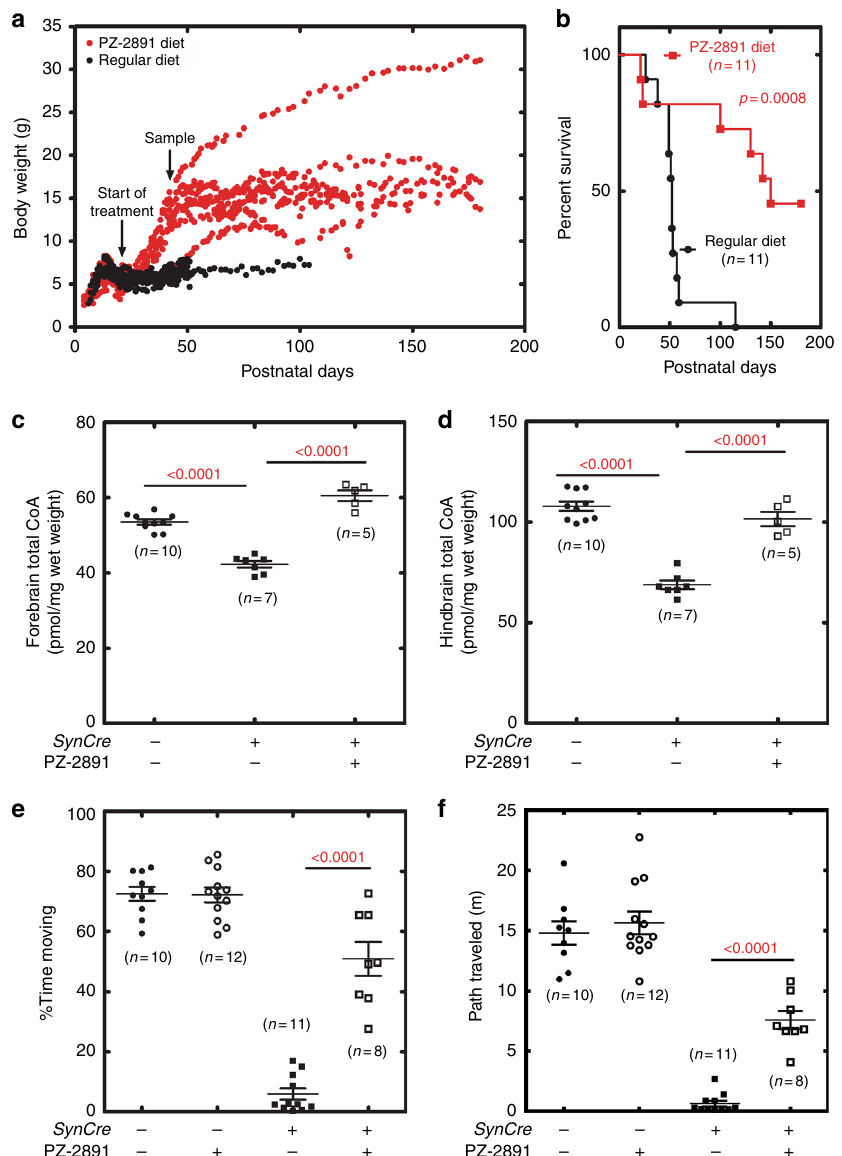
Fig. 7 PZ-2891 therapy in SynCre + PANK1,PANK2 neuronal knockout mice. Male and female mice were randomized into the experimental groups when they were genotyped, and the numbers of mice used in each analysis are shown in parenthesis in the fi gure panels. a Weight monitoring of double knockout mice maintained on the control diet (black circles) or on a diet with PZ-2891 (red circles). The start of treatment and the time of sample collection are indicated with arrows on the fi gure. b Lifespan of double knockout mice with (red line) or without (black line) PZ-2891 treatment. c Forebrain CoA levels in littermate control ( SynCre − ) mice ( fi lled circles) compared to SynCre + Pank1,Pank2 neuronal knockout mice at day 45 with (open squares) or without ( fi lled squares) PZ-2891 therapy. d Hindbrain CoA levels in littermate control ( SynCre − ) mice ( fi lled circles) compared to SynCre + Pank1,Pank2 neuronal knockout mice at day 45 with (open squares) or without ( fi lled squares) PZ-2891 therapy. e The percent time mice were moving during the 5 min open fi eld test. Littermate control ( SynCre − ) mice (untreated, fi lled circles; treated open circles) were compared to SynCre + Pank1,Pank2 neuronal knockout mice (untreated fi lled squares; treated, open squares) at day 45 with or without PZ-2891 therapy. f Distance traveled by mice in the 5 min open fi eld test. Littermate control ( SynCre − ) mice (untreated, fi lled circles; treated, open circles) were compared to SynCre + Pank1,Pank2 neuronal knockout mice at day 45 with (open squares) or without (closed squares) PZ-2891 therapy. The p values are in red, and means ± SEM are